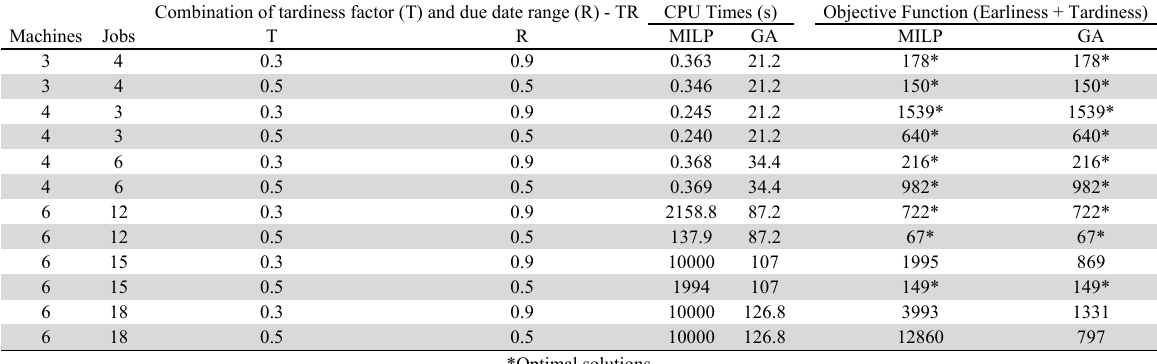
Computational results of small